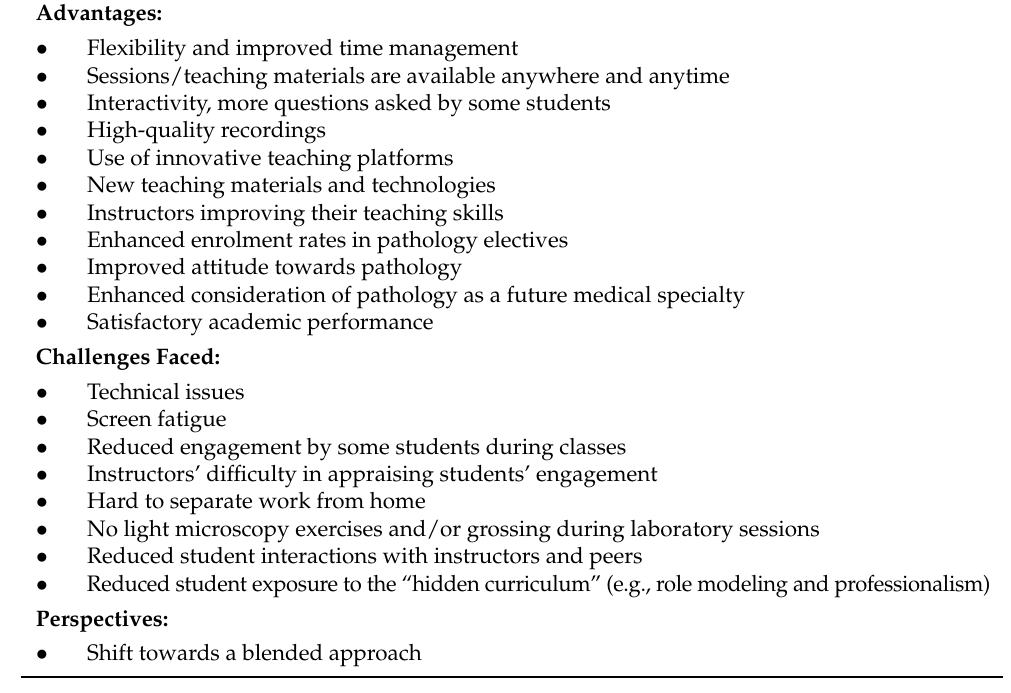
Table 4. A summary of advantages, challenges faced, and perspectives regarding virtual pathology education, as shown in the “literature review” and “our own